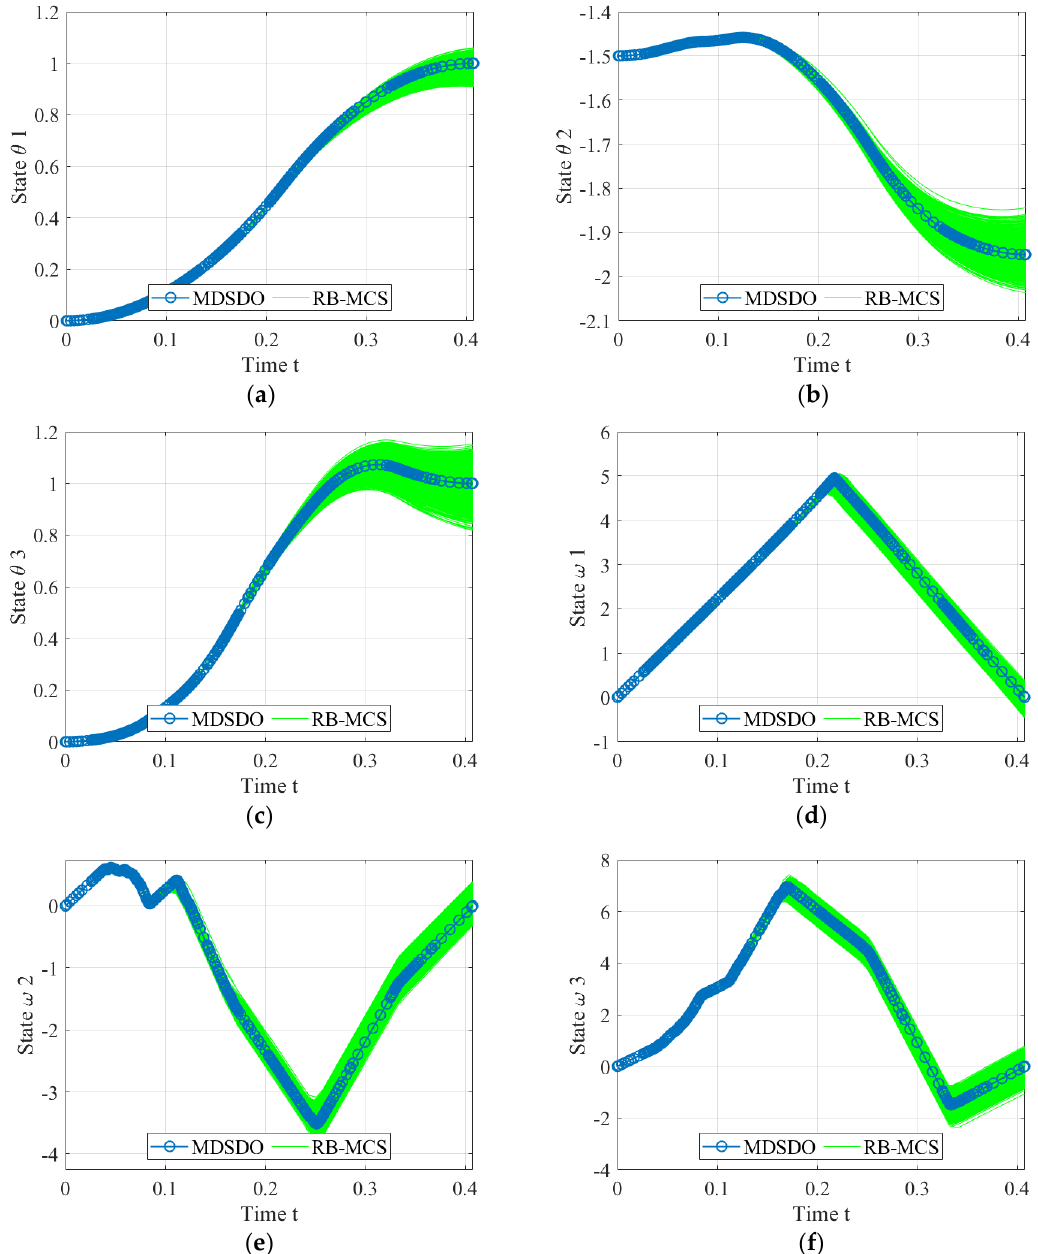
Figure 13. The uncertainty influence on state trajectories under MDSDO. ( a ) State trajectories of θ 1 . ( b ) State trajectories of θ 2 . ( c ) State trajectories of θ 3 . ( d ) State trajectories of ω 1 . ( e ) State trajectories of ω 2 . ( f ) State trajectories of ω 3